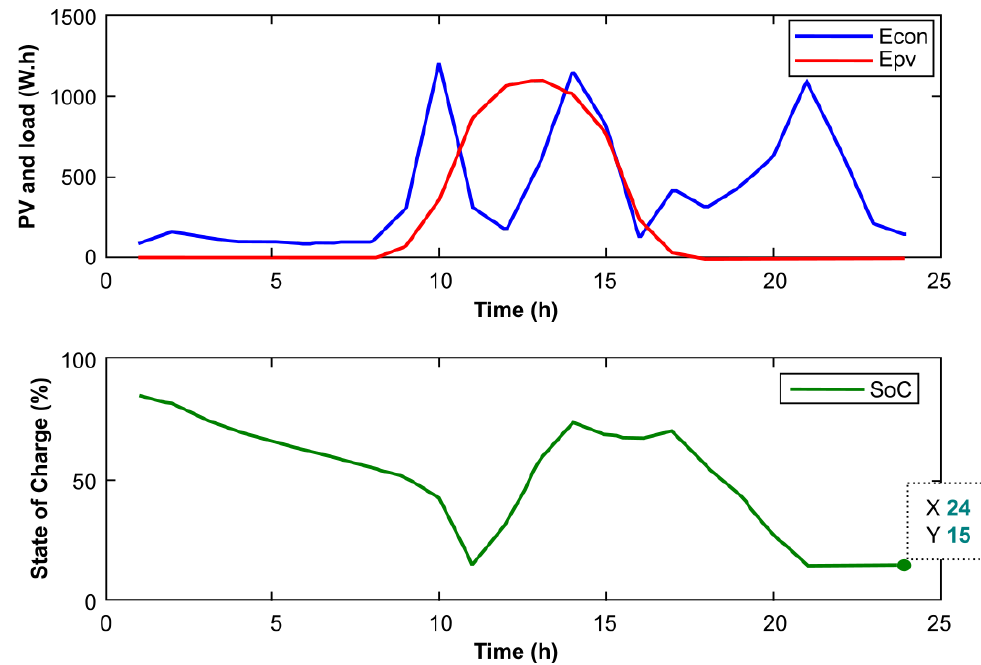
Figure 9. Daily evolution of individual SoCs according to PV and consumption binomial.